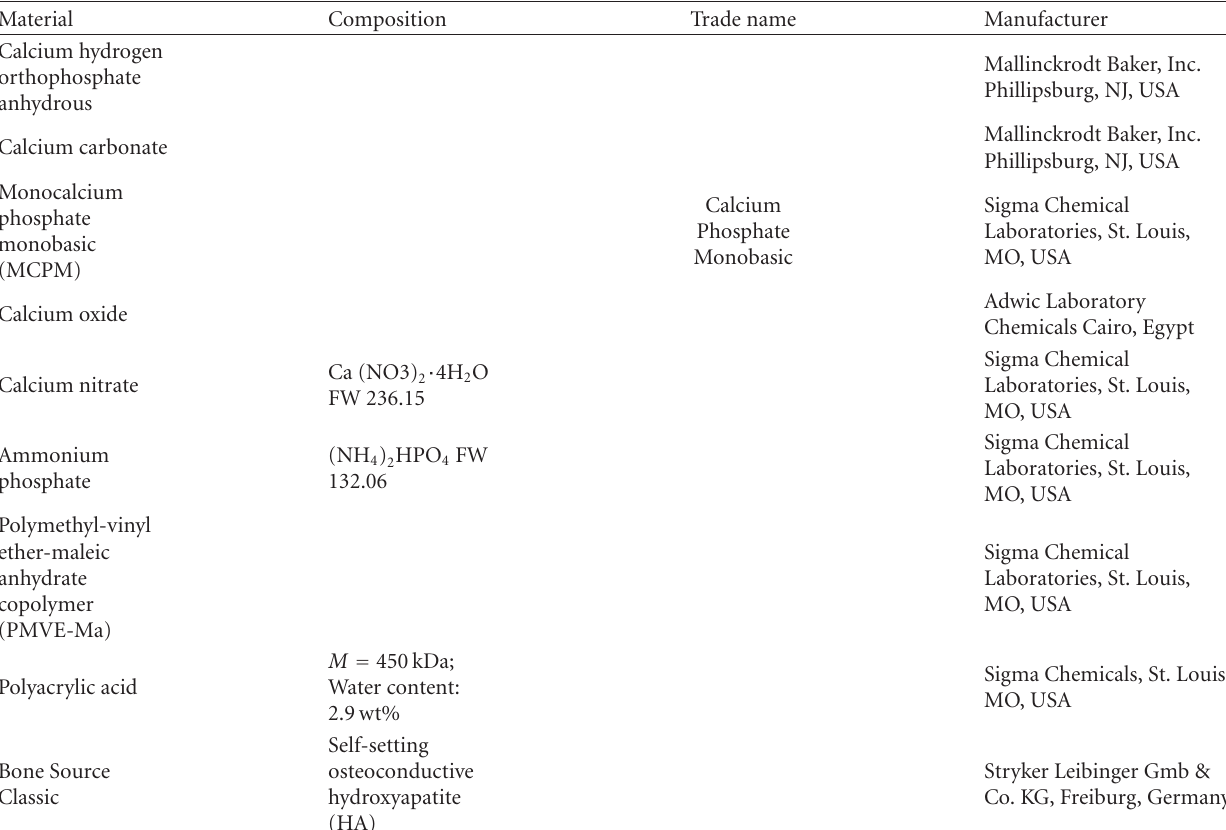
Table 1: Composition of the materials used in this